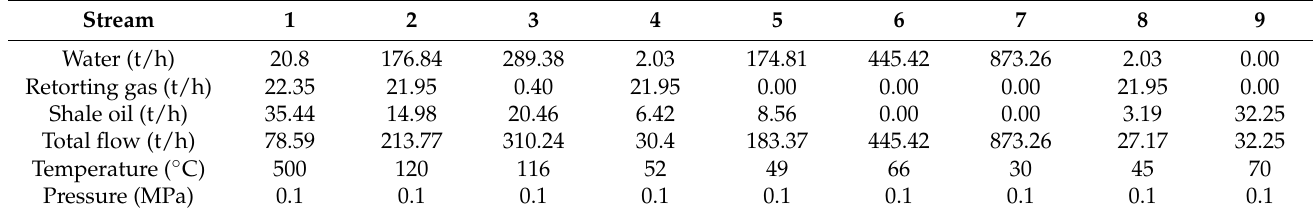
Table 5. Simulation results of the oil–gas separation